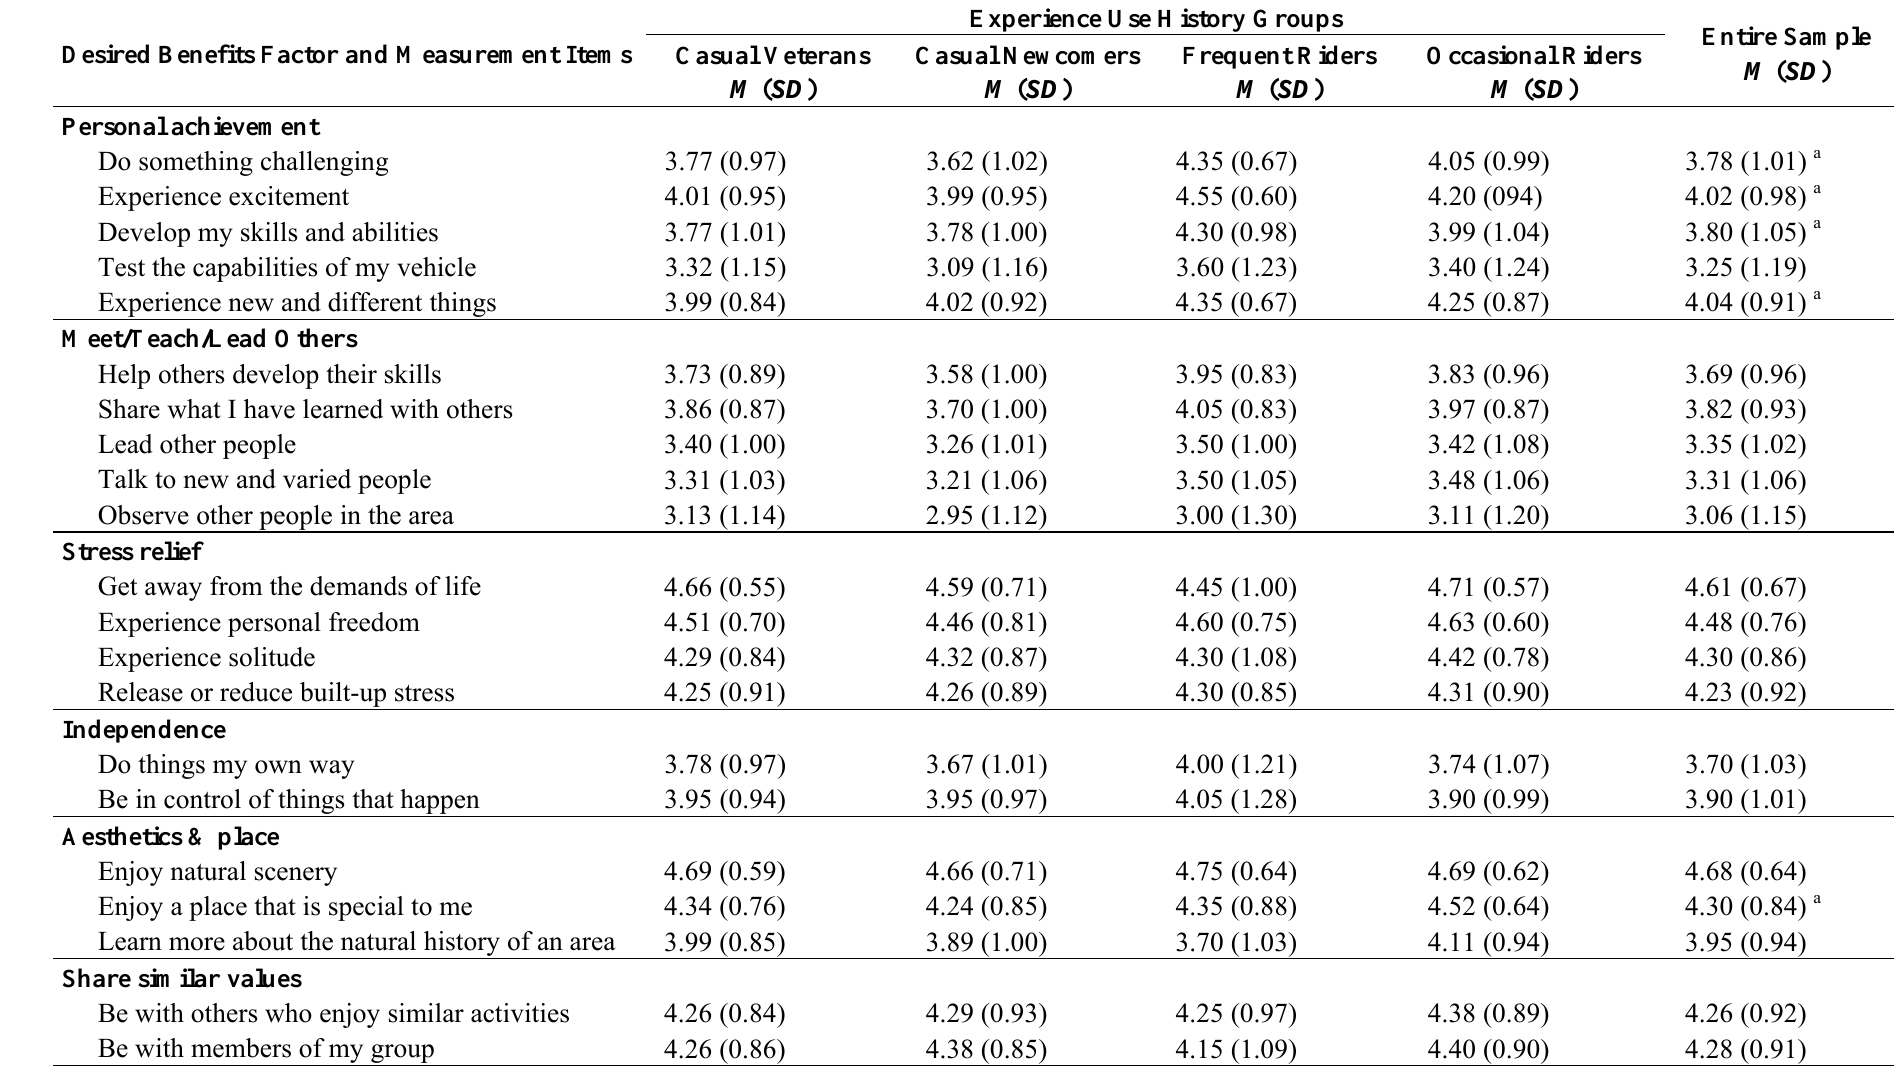
Table 4. Descriptive Statistics of recreation experience preferences by EUH